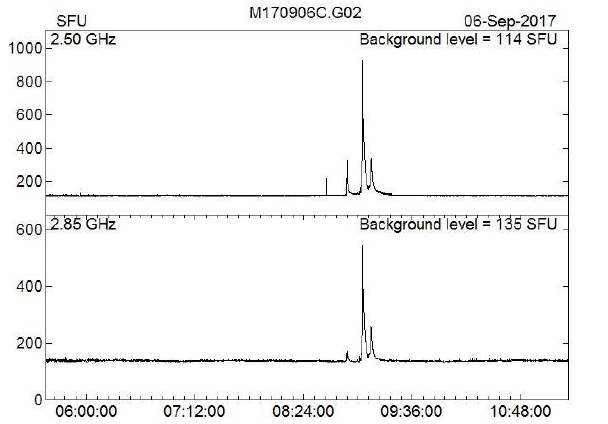
Fig. 3. Spectral fluxes of radio emission registered by RT-3 at a frequency of 2.5 GHz and 2.85 GHz. The graph clearly shows that a strong radio burst occurred at 09:10 UT with a power of 691 SFU at 2.5 GHz and 578 SFU 2.85 GHz.